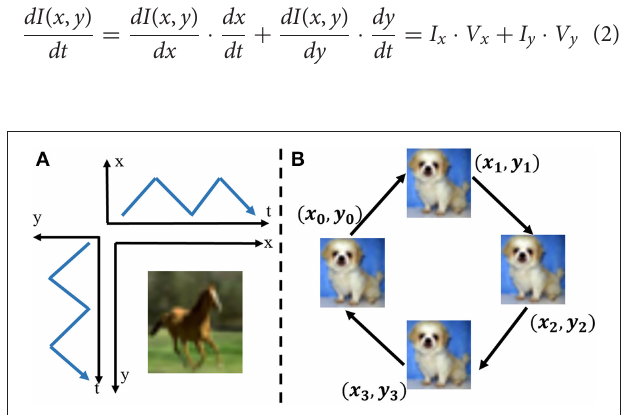
FIGURE 1 | (A) Image movement along x axis and y axis simultaneously over time in the 2D intensity field. The moving image generates the local intensity changes in both x direction and y direction at the same time. (B) The RCLS movement of an image. Four paths make up the closed-loop movement. Each path is at the angle of 45 ◦ .